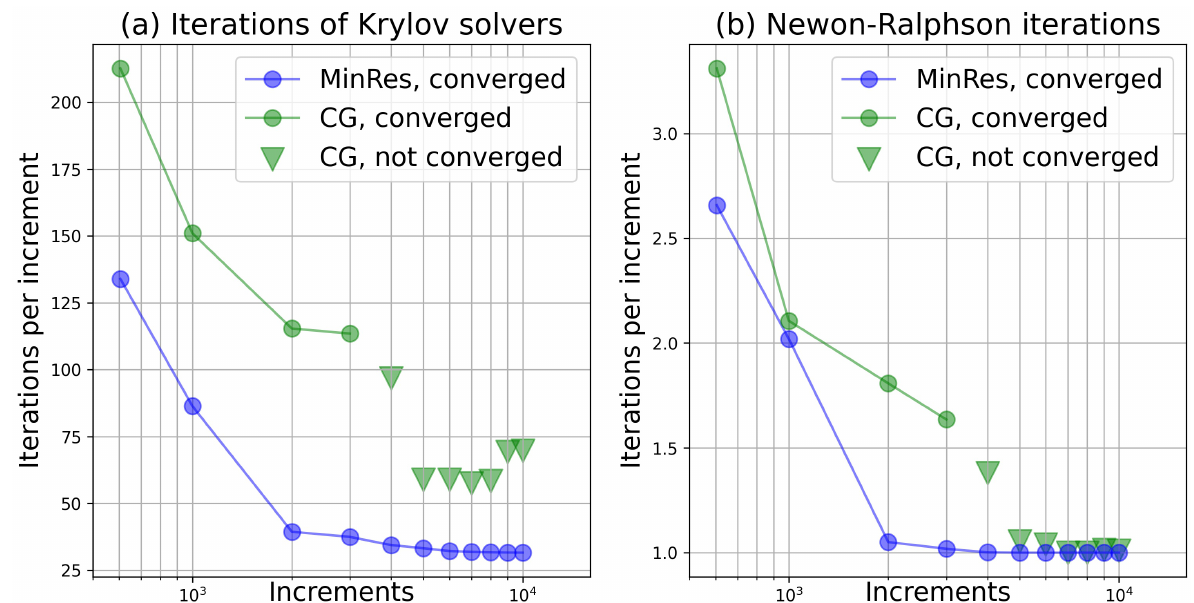
Figure 4. Performances of the MinRes and CG solvers in the single-point calculator as functions of the total number of increments for the simulation (presented in Section 3.1.2) with the single crystal plasticity model. The calculation is not converged with the CG solver when the number of increments is superior to